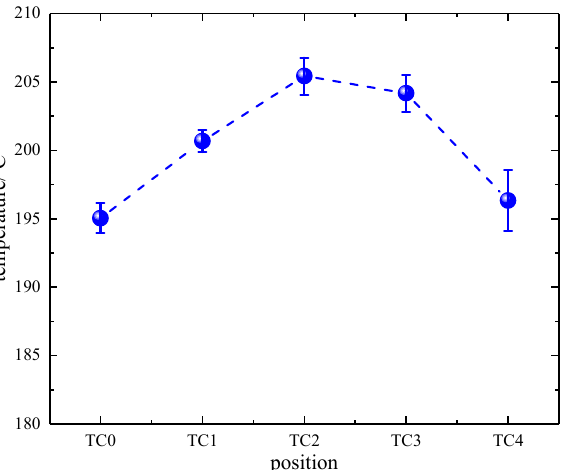
Figure 3. Preheating temperature distribution at different depths of the catalytic bed.